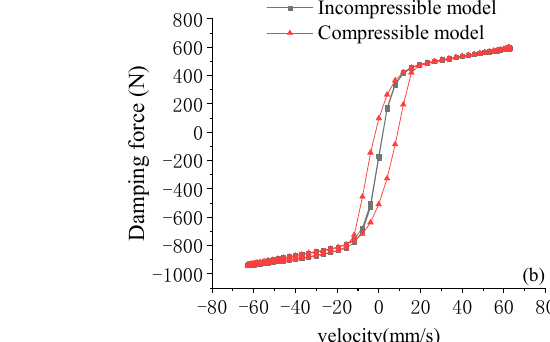
Figure 10. Damping characteristic contrast considering compressibility and incompressibility: ( a ) damping force–displace- ment; and ( b ) damping force–velocity.